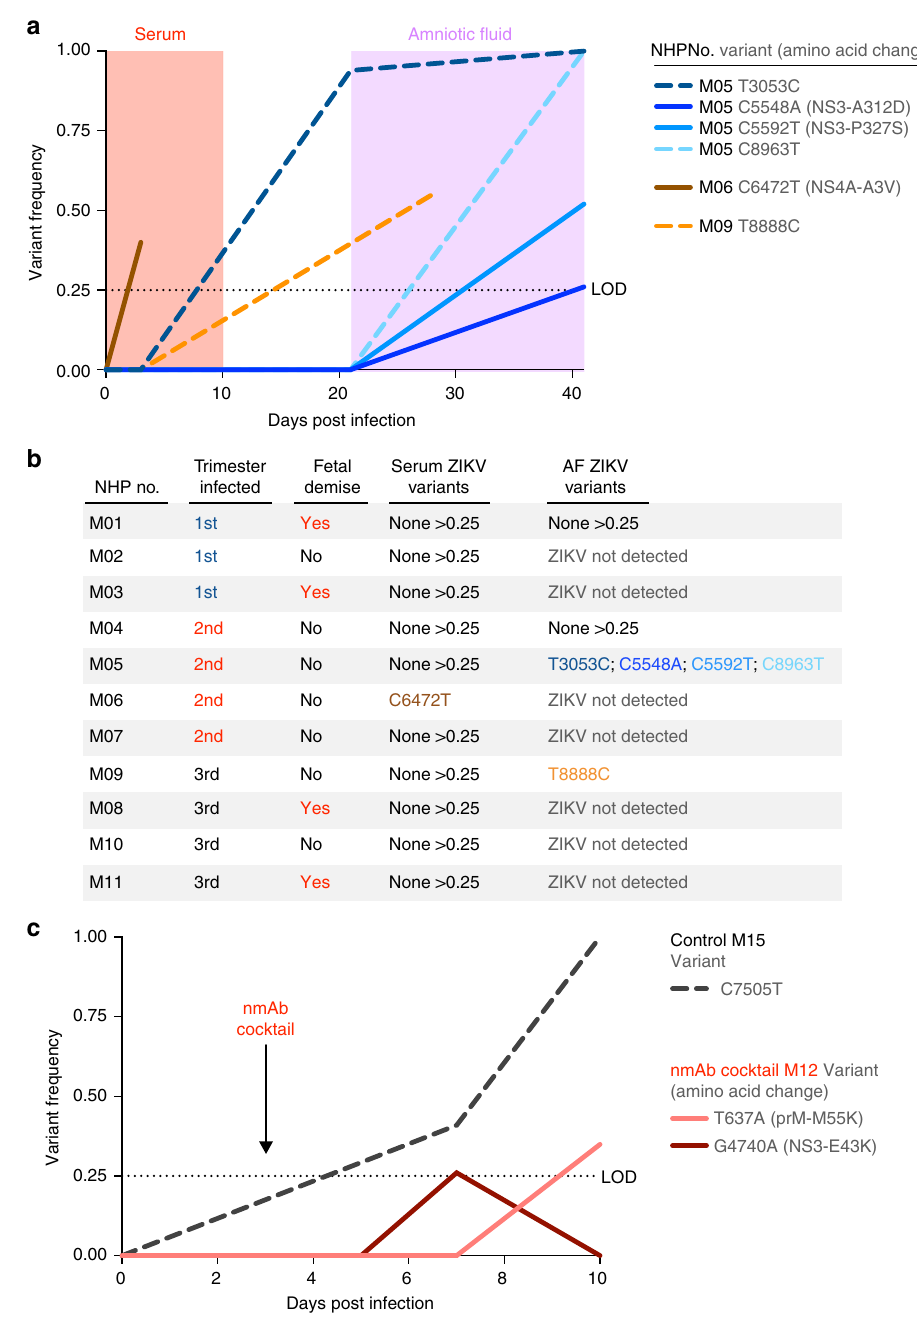
Fig. 4 De novo mutations in the consensus sequences are not required for in utero transmission, fetal demise, or antibody escape during pregnancy. ZIKV from serum and AF was sequenced using a PCR amplicon-based approach. A very conservative 0.25 frequency cut-off was used detect high frequency intrahost variants. a ZIKV intrahost variant frequencies were plotted by the sample source (serum or AF) and days post infection. All blue lines indicate different ZIKV variants sequenced from the same macaque (M04). b ZIKV intrahost variants >0.25 corresponding to a speci fi c macaque, trimester of infection, and fetal demise are also shown in a table for clarity. c Following nmAb cocktail treatment, one pregnant NHP (M12) failed to control viral replication in the blood. Intrahost ZIKV variants sequenced from the serum of M12 and a no-antibody control were plotted by frequency and days post infection. Variants shown as solid lines represent nonsynonymous mutations and variants shown as dashed lines represent synonymous. The dotted lines at 0.25 frequency represent the limits of detection